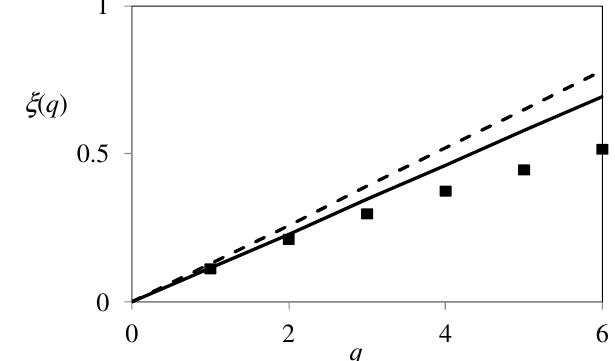
Fig. 15. ξ ( q) as a function of q (symbols) obtained via ESS based on ξ ( 1 ) = 0 . 12 computed for Utah data from transects D and H (bioturbated sandstone) by method of moments. Solid line has slope ξ ( 1 ) = 0 . 12 and broken line has slope H =0.13.